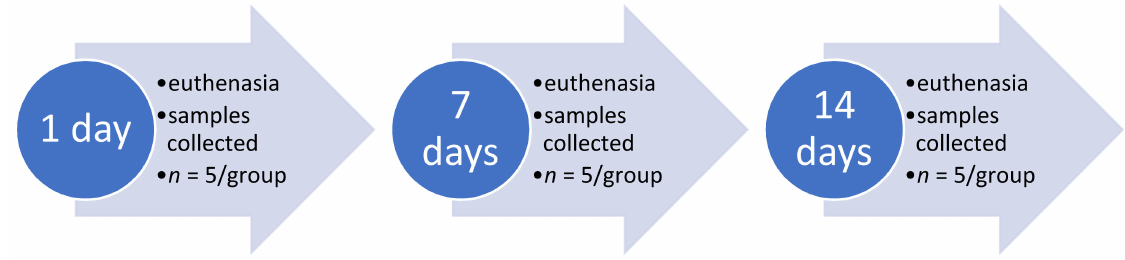
Figure 7. Flow chart showing the experimental